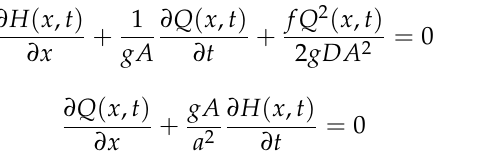
Figure 3. Single characteristic computing pipe.